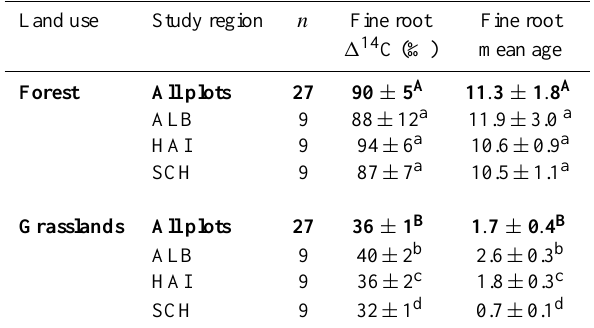
Table 4. Mean values of 14 C content and mean age of fine roots ( < 2mm) among land-use types and study regions (mean ± SE). Two-way ANOVA results are presented with Holm’s test ( p < 0.05). Significant differences between study regions are in- dicated by lowercase letters and between land-use types by capital